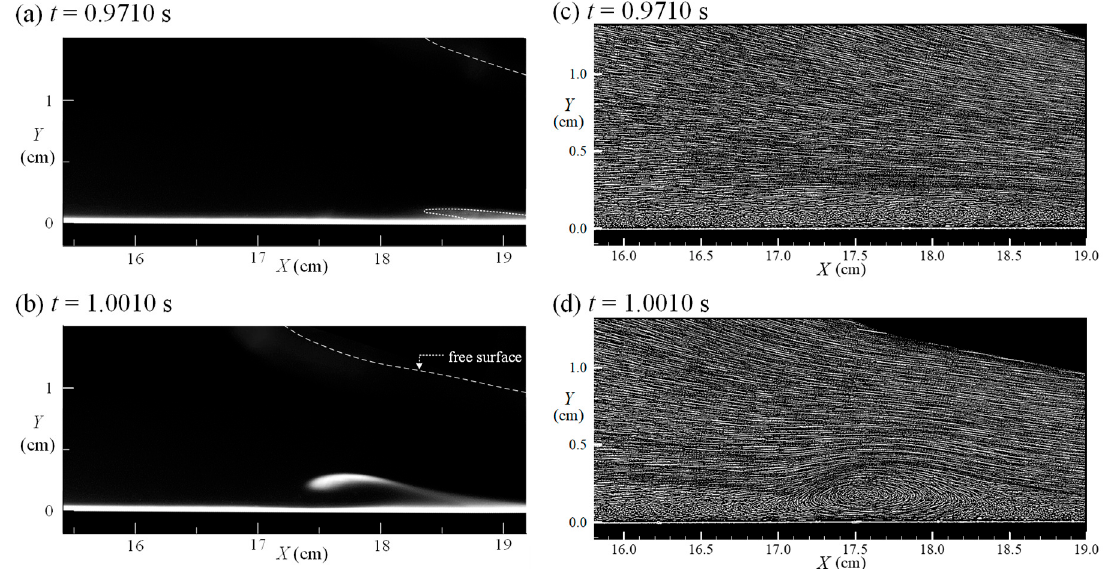
Figure 11. The streaklined and pathlined images (displayed in the left and right panels, respectively) showing growth of the separated shear layer and development of the primary vortex at t = ( a , c ) 0.9710 s; and ( b , d ) 1.0010 s.